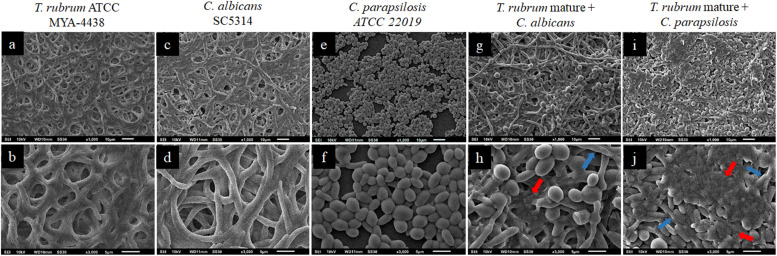
Scanning electron microscopies of T. rubrum ATCC MYA 4438 (a,b), C. albicans SC 5314 (c,d), and C. parapsilosis ATCC 22019 (e,f) monospecies biofilms and dual-species biofilms of C. albicans/T. rubrum
(g,h) and C. parapsilosis/T. rubrum
(i,j), formed after the maturation of T. rubrum biofilm, followed by an additional 48 h incubation. It is possible to observe oval blastoconidia. Red arrows denote the extracellular matrices, while blue arrows denote hyphae.